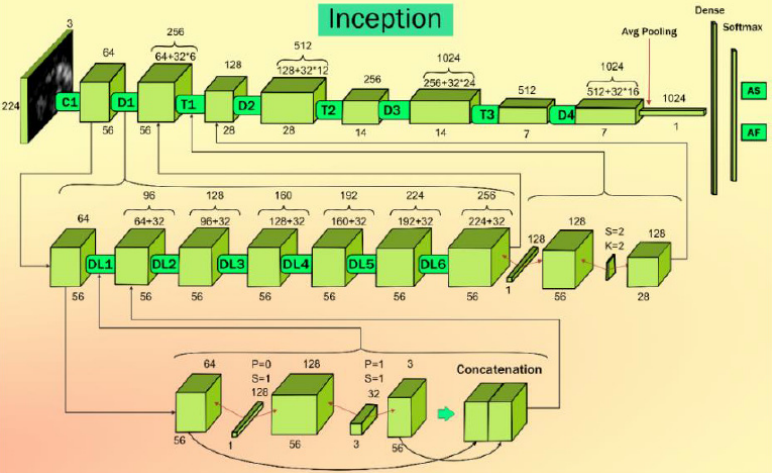
Figure A3. The general structure of the InceptionV3 architecture [44].